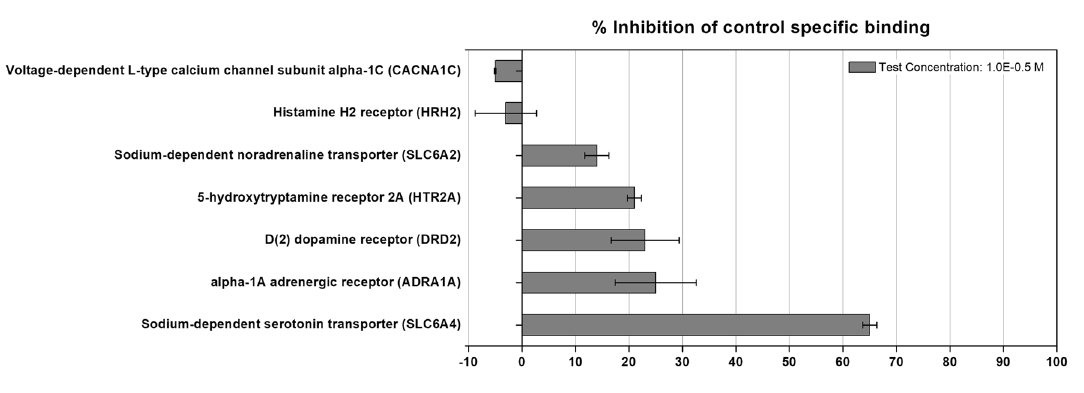
Figure 6. Experimental validation of potential targets of